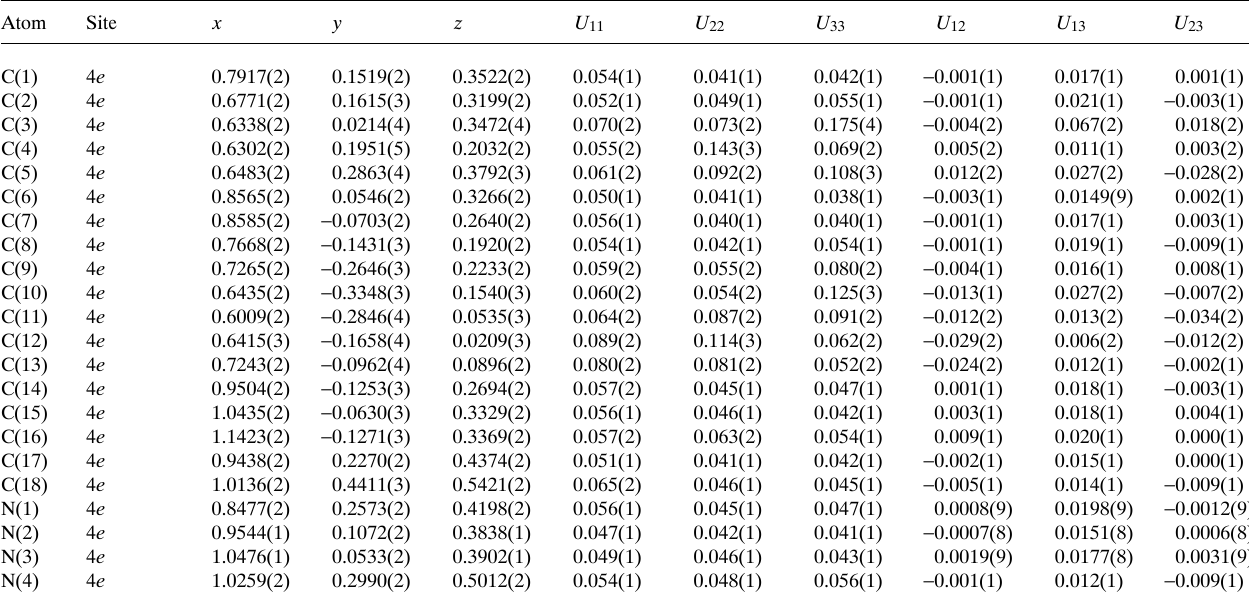
Table 3. A tomic coordin a tes a nd displ a cement p a r a meters (in Å 2 )